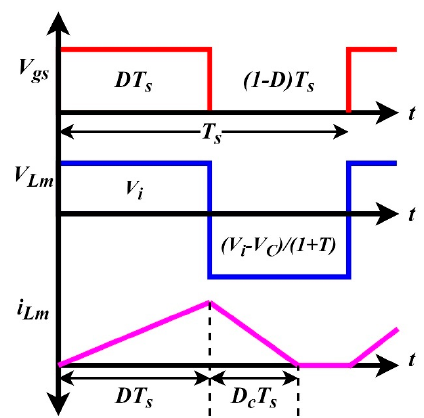
Figure 4. Theoretical waveform of the proposed converter during DCM.